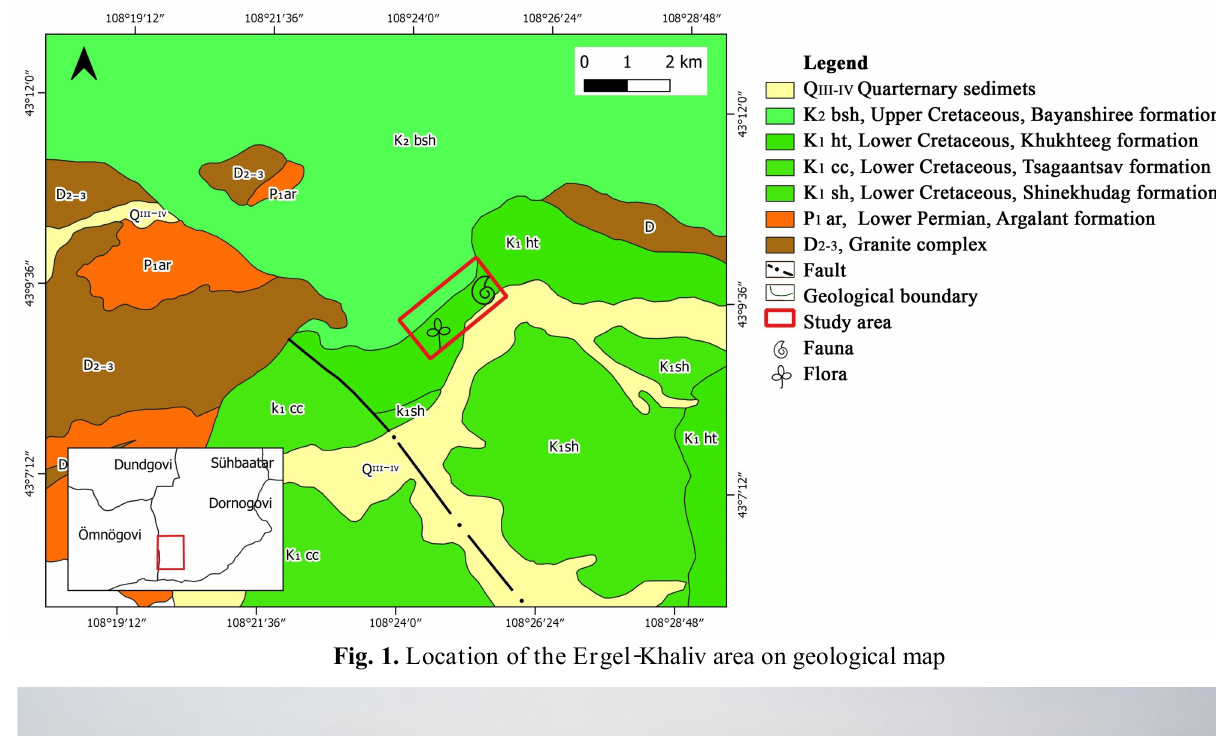
Fig. 1. Location of the Ergel-Khaliv area on geological map